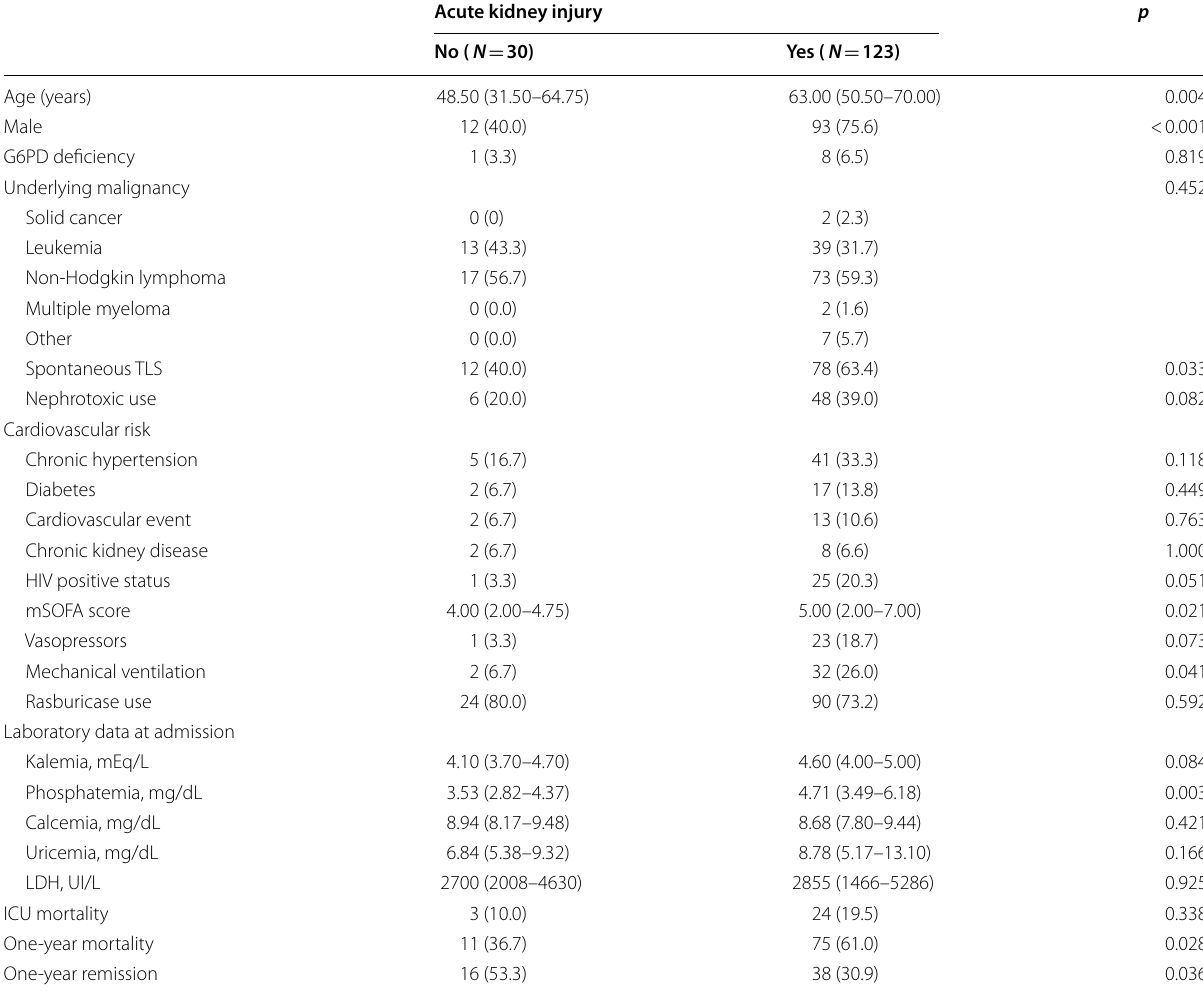
Results are reported as n (%) or median (IQR)